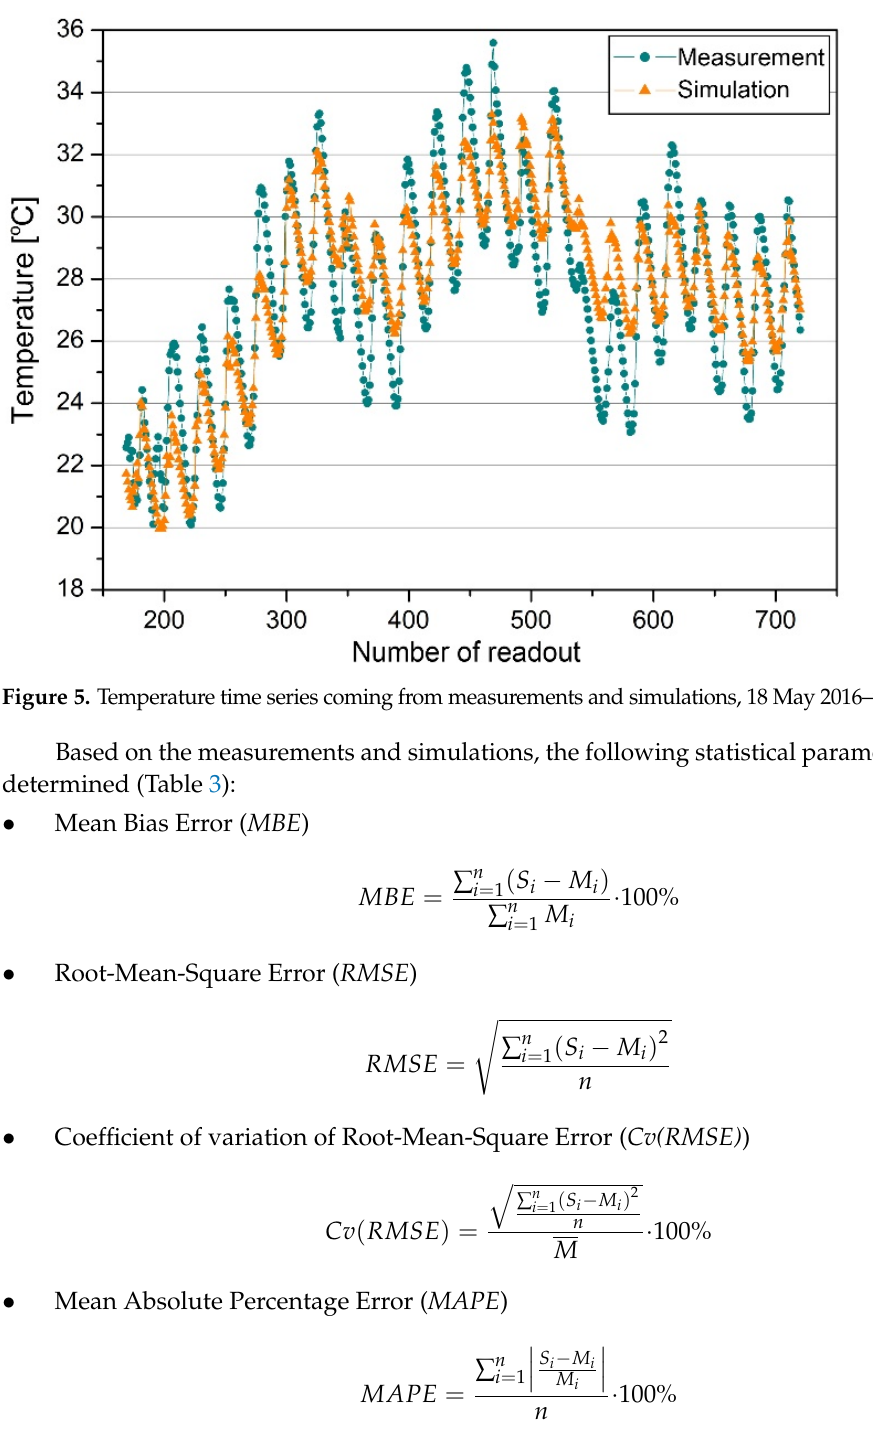
temperature, the temperature on the surface of full and glazed partitions as well as heat fluxes flowing through the glazing were recorded at intervals of 10 minutes. The following parameters of the external environment were measured at the same time intervals: out- side air temperature and humidity, pressure, wind direction and speed, solar radiation intensity on the horizontal plane. The air temperature obtained from the computer model was compared with the temperature measured in the chamber in the validation process (Figure 5).